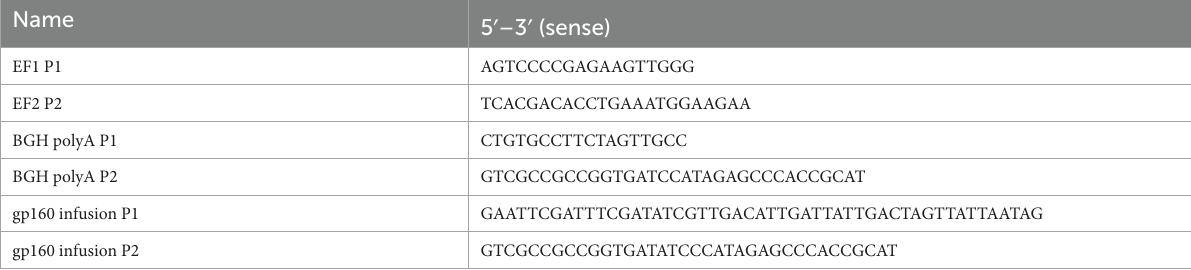
TABLE 1 Primer pairs used to construct the recombinant virus in this study.